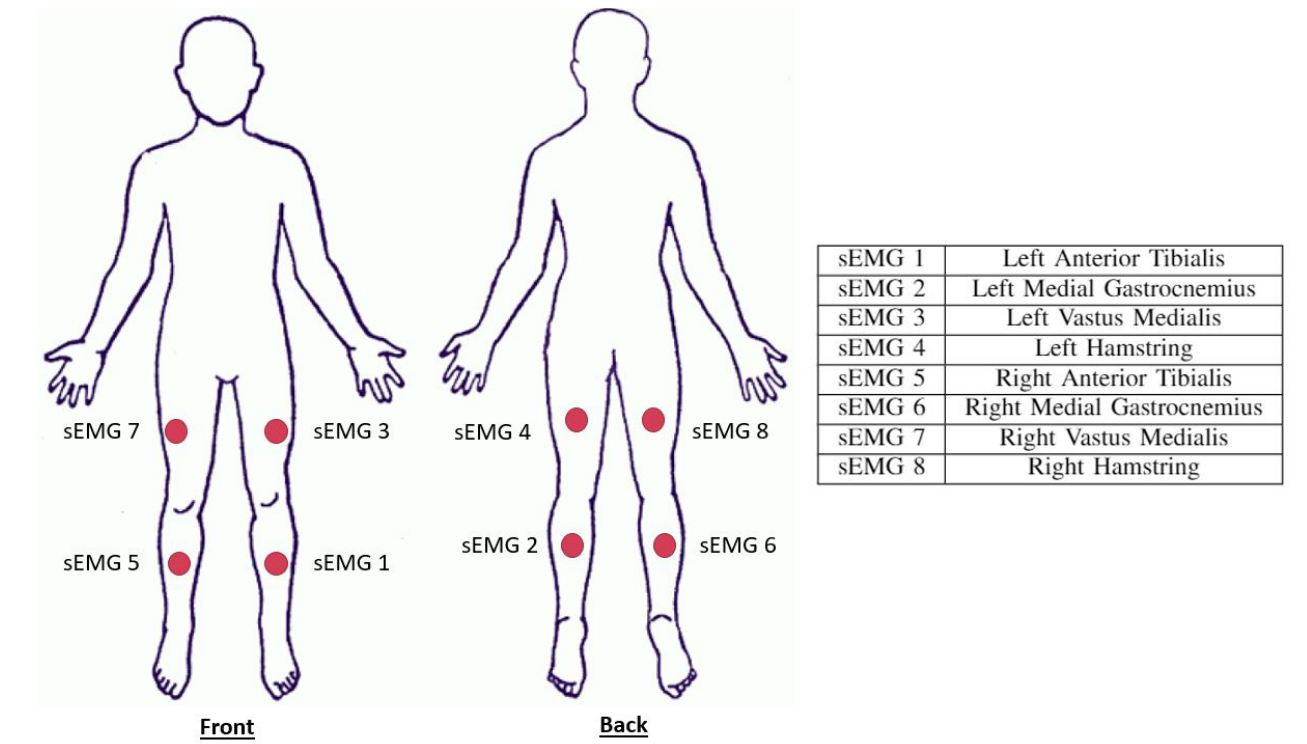
Figure 1. Trigno sensor locations on the subjects. These sensors include both a surface electromyography sensor (sEMG) and an